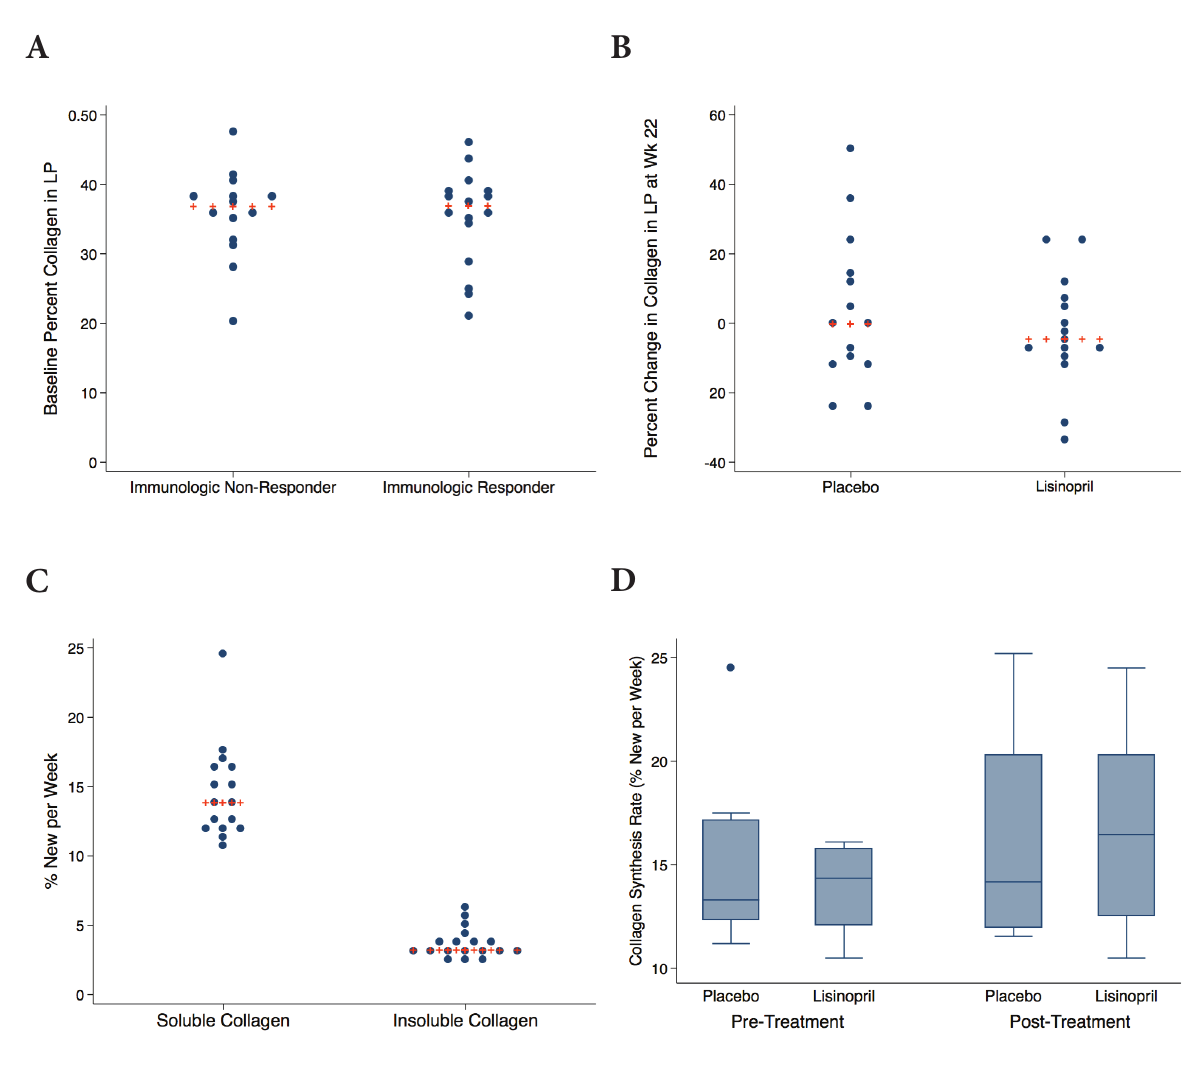
Figure 4. (A) Baseline percent collagen deposition by immune responder status. Plus signs denote the me- dian. (B) Percent change in collagen deposition in the lamina propia (LP) at week 22. (C) Baseline collagen synthesis rates (percent new per week) of guanidine-soluble and guanidine-insoluble collagen in all partic- ipants measured by heavy water labeling. (D) Change in collagen synthesis rates (percent new per week) of guanidine-soluble collagen in the placebo and lisinopril groups at baseline and at week